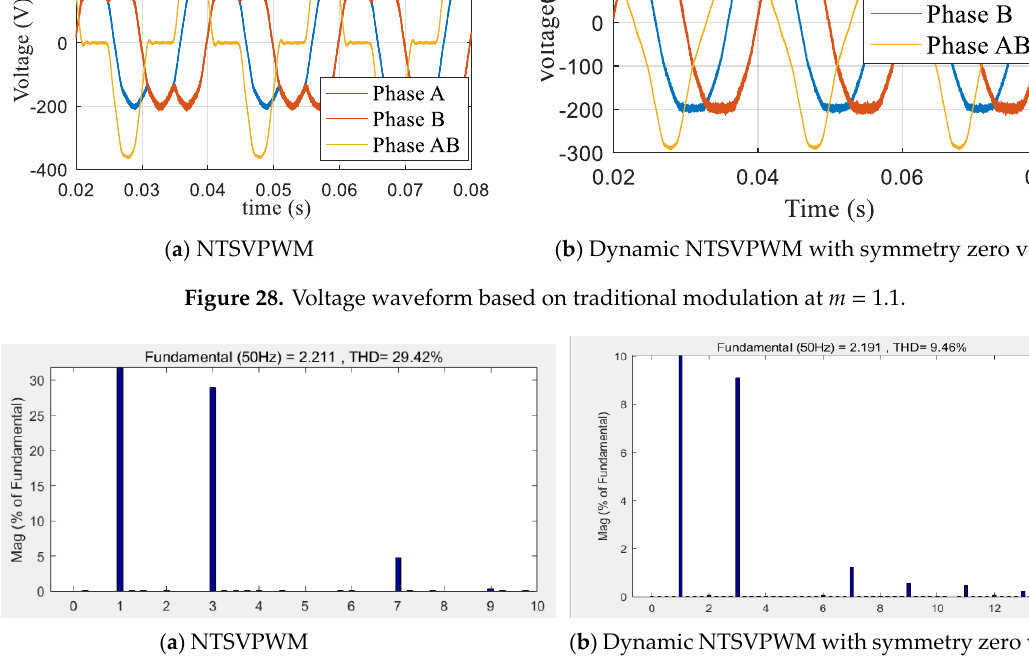
Figure 29. Harmonic characteristics at m = 1.1.